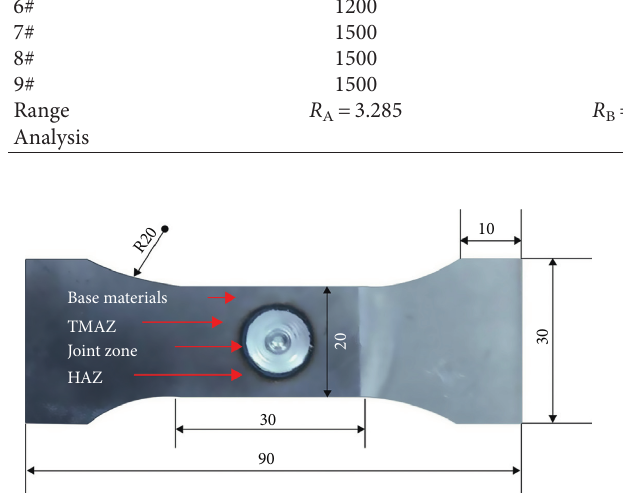
Figure 3: Macrograph of the welding